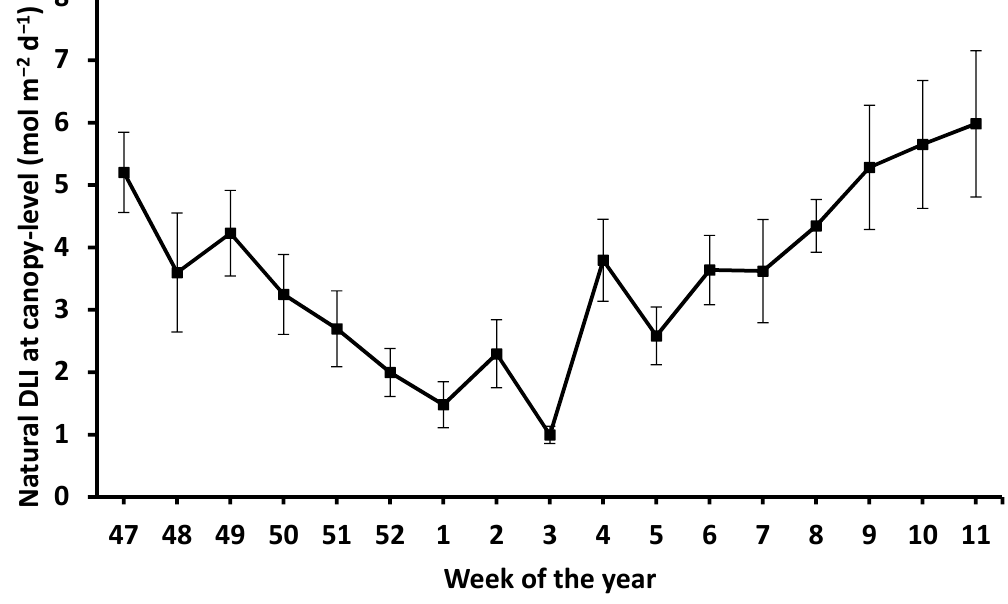
Figure 1. Weekly natural daily light integral (DLI) at canopy level (average ± SE, n = 7). The overall average natural DLI, during the 17-week trial, was 3.6 mol m − 2 d − 1 . The supplemental PPFD treatments ranged from 40.7 to 179 µ mol m − 2 s − 1 , corresponding to 1.8 to 7.7 mol m − 2 d − 1 of daily supplemental PAR with a 12 ‐ h photoperiod (Table 1).